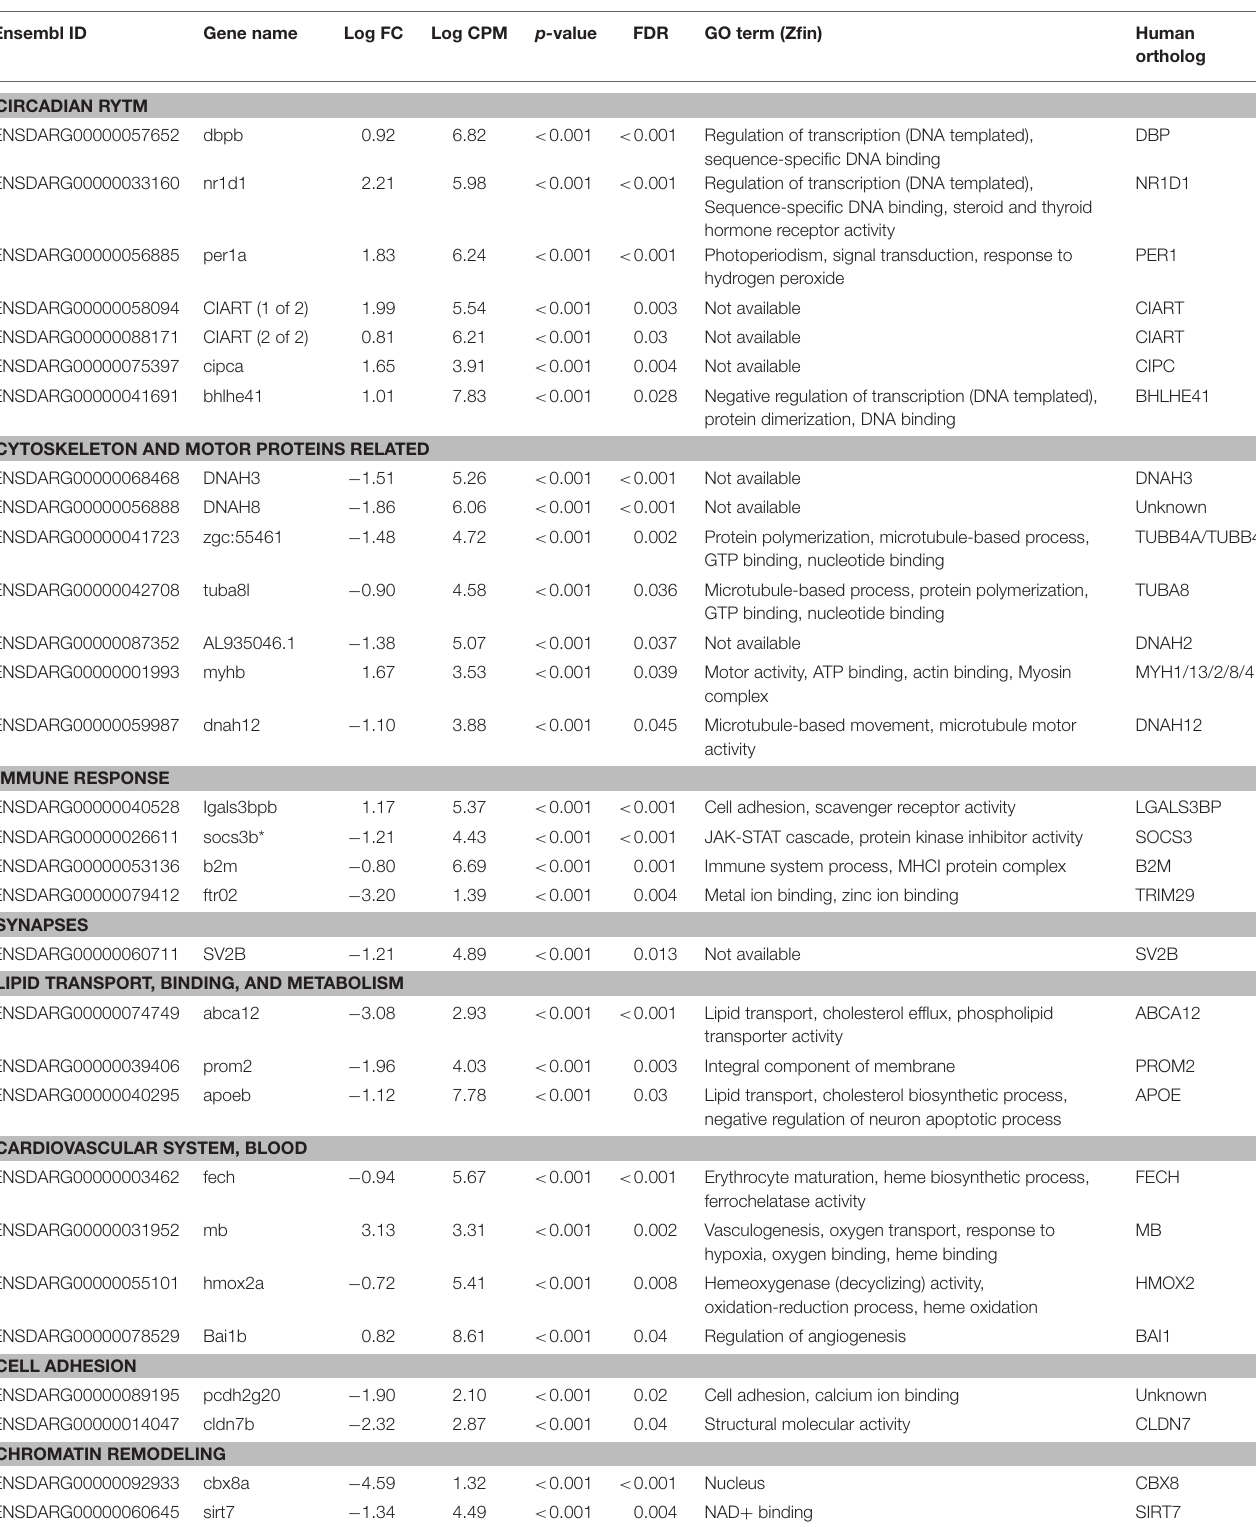
TABLE 4 | List of protein coding genes significantly affected in brains of female zebrafish developmentally exposed to 10ng/L EE 2 compared to non-exposed fish after 120 days of recovery in clean water. Ensembl